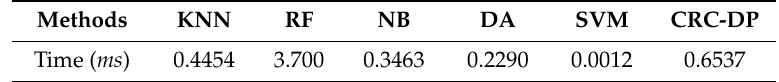
Table 2. Mean online identification time of each query sample for three-class classification.